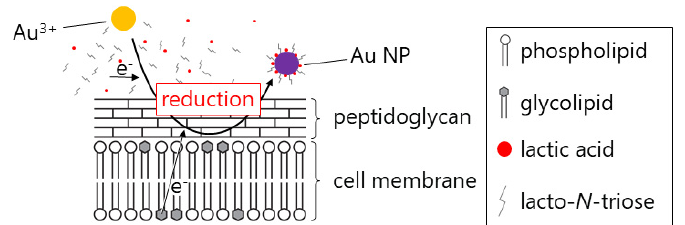
Figure 6. The mechanism of Au NPs synthesis by L. casei . Au ion was reduced by diglycosyldiacylglycerol (DGDG) (glycolipid in cell membrane) and lacto- N -triose. Au crystals were kept small by lactic acid secreted from the cell.